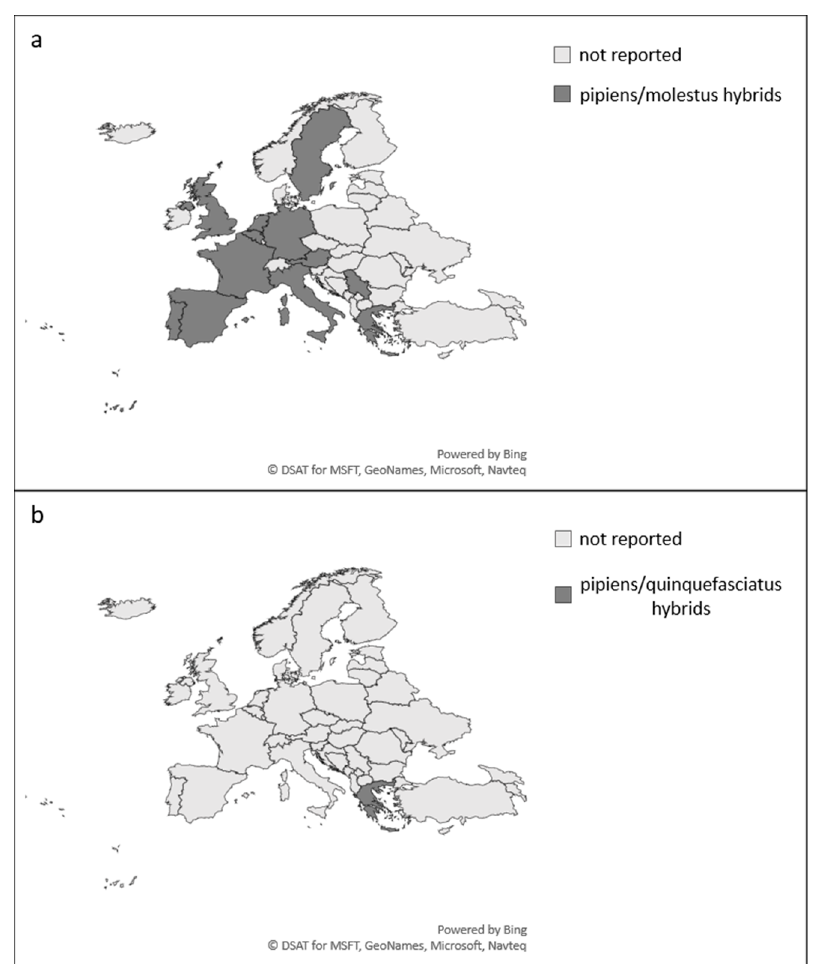
Figure 2. European country-level reports of natural hybrid populations of ( a ) Culex pipiens forms pipiens/molestus hybrids; ( b ) Culex pipiens / Culex quinquefasciatus hybrids. References available in Appendix A.